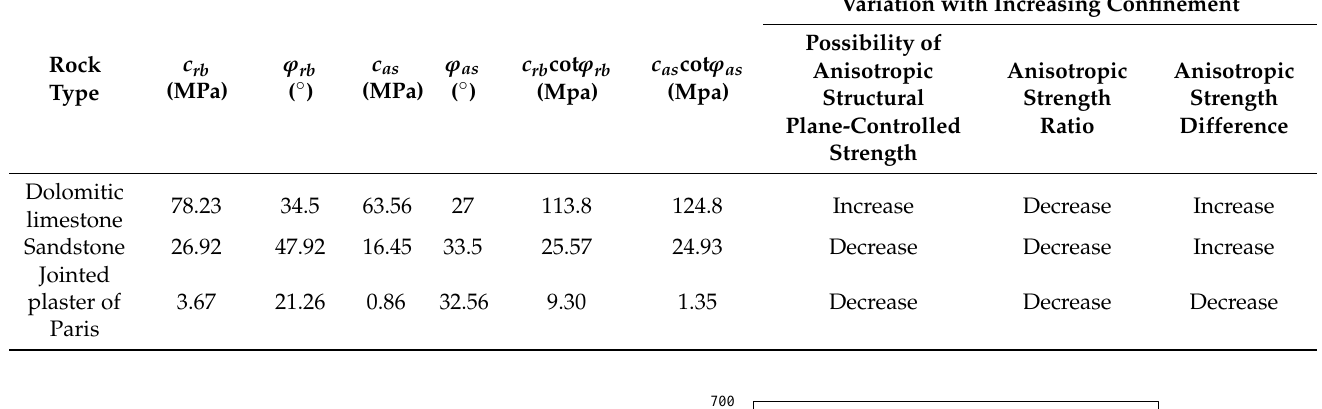
Figure 3. The types of discontinuity. The fresh rough contact joint is well-exhibited in ( a ), while the filled layer becomes thicker and thicker ( b – d ) denoting the soft discontinuous layer. Table 1. Strength parameters of anisotropic rock mass.